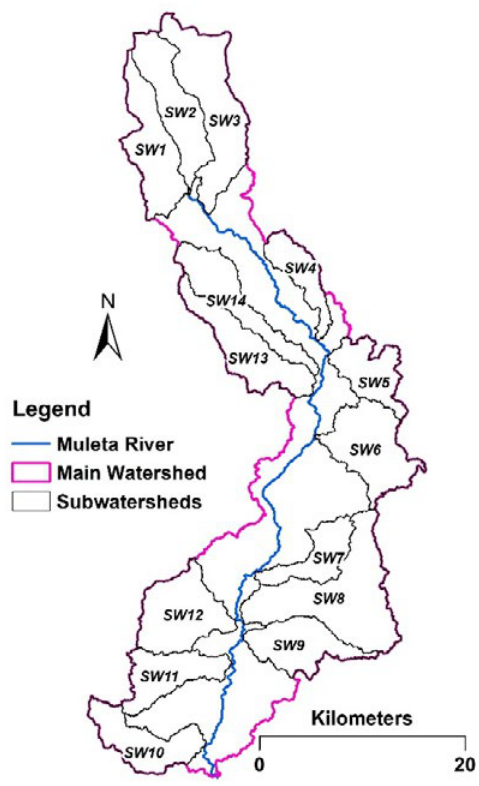
Fig. 3. Subwatersheds of Fig. 3: Subwatersheds of Muleta